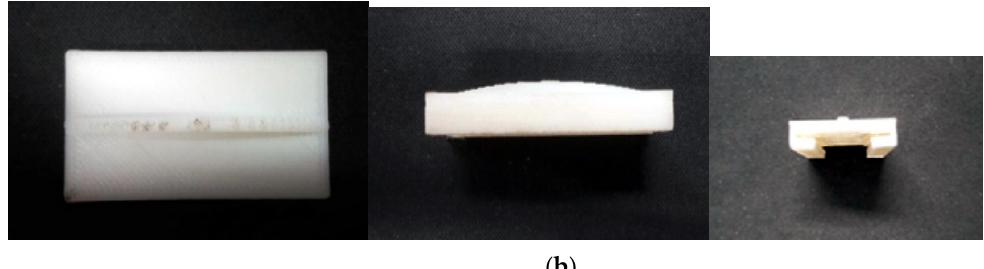
Figure 6. ( a ) Schematic diagram of PZT (piezo patch) protector made by AutoCAD. ( b ) Three-view of Figure 6. ( a )Schematic diagram of PZT (piezo patch)protector made by AutoCAD. ( b )Three-view of the protector product model. the protector product model. Table 3. Power benefits of different cambers of the PZT protector .